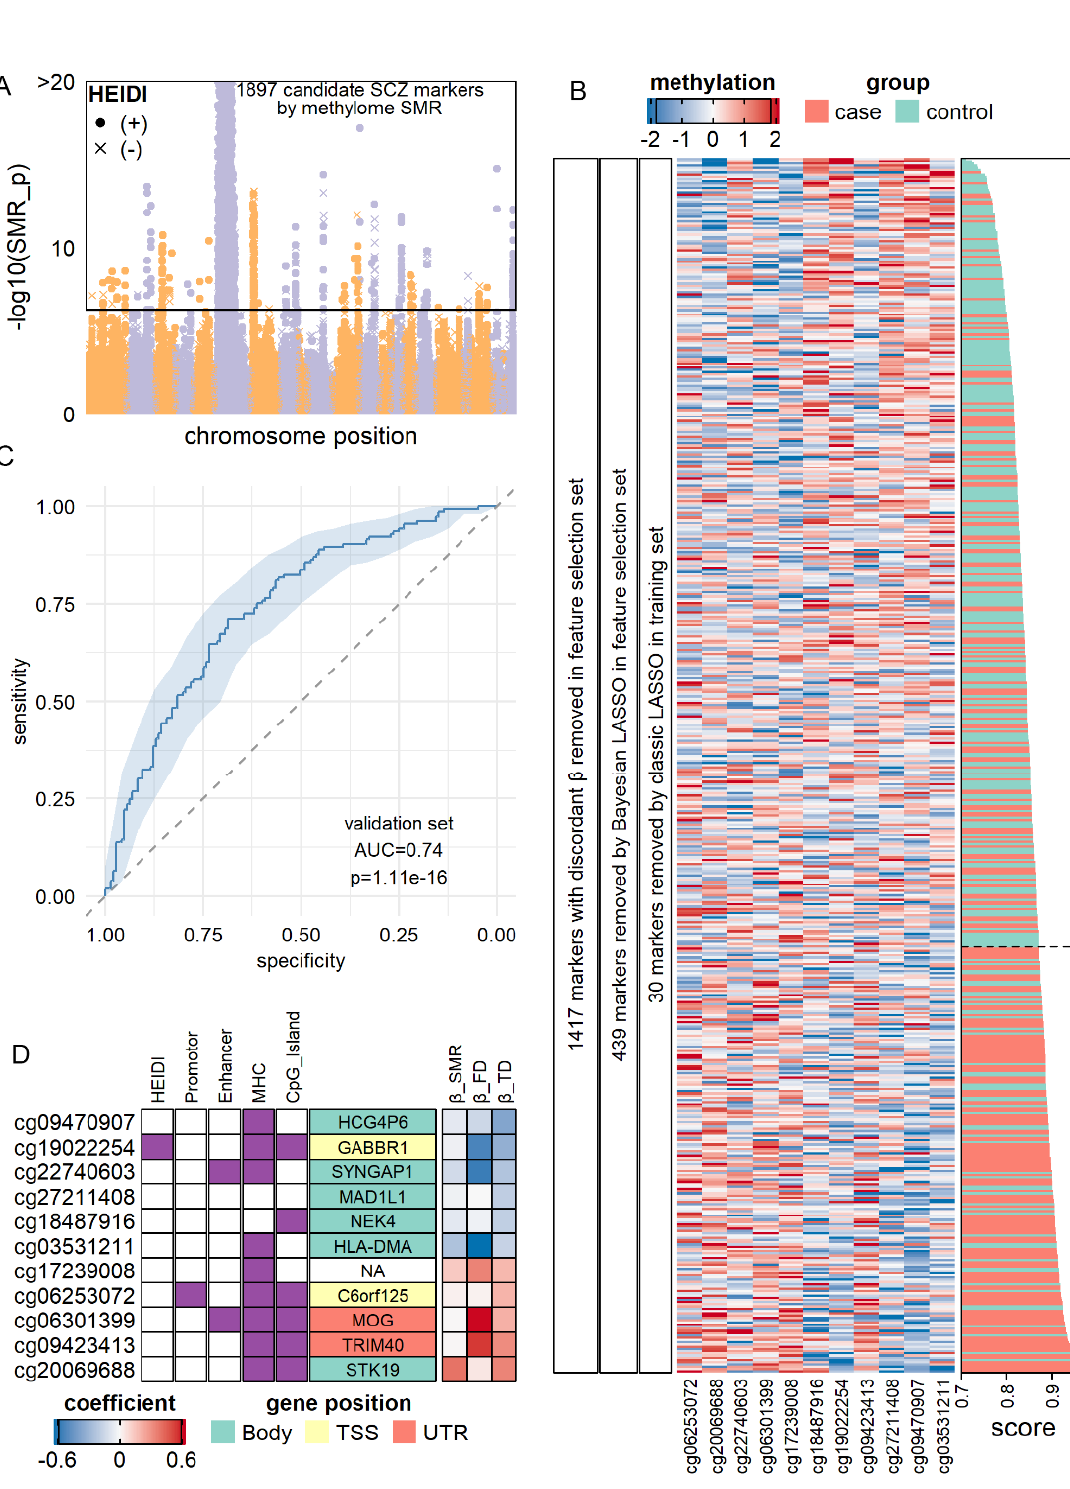
Figure 4. Validation of methylation markers of SCZ. ( A ) Manhattan plot for SCZ-methylation association by SMR. Each dot represents a methylation site. ( B ) LASSO model of SCZ diagnostic model by methylation markers in the training set (N = 547). Heatmap showed the expression levels of 11 markers after filtration and model construction in the training set. Score: diagnostic scores calculated by the sum of methylation levels weighted by the LASSO coefficient. A higher score corresponded to a higher probability of being an SCZ patient. ( C ) Receiver-Operation Curve for LASSO model in the validation set (N = 300). ( D ) Characteristics of methylation markers chosen by LASSO. Gene symbols denoted the proxy genes of each methylation marker, and their grid color denoted the position of the methylation markers on the proxy genes. Purple girds on column “HEIDI” indicated that the markers had p > 0.05 in HEIDI. β FD : coefficients in the feature selection set. β TD : coefficients in the training